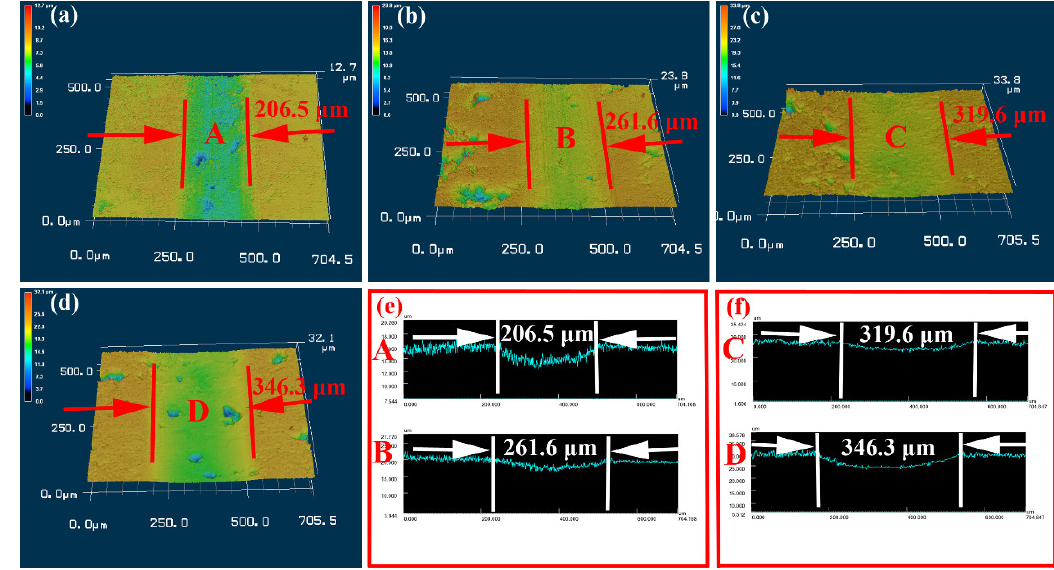
Figure 6. 2D and 3D configurations of NiCrAlY coating worn surfaces in different corrosive solutions: ( a ) deionized water, ( b ) artificial seawater, ( c ) HCl solution and ( d ) NaOH solution; ( e ) 2D profiles of A and B regions; ( f ) 2D profiles of C and D regions.